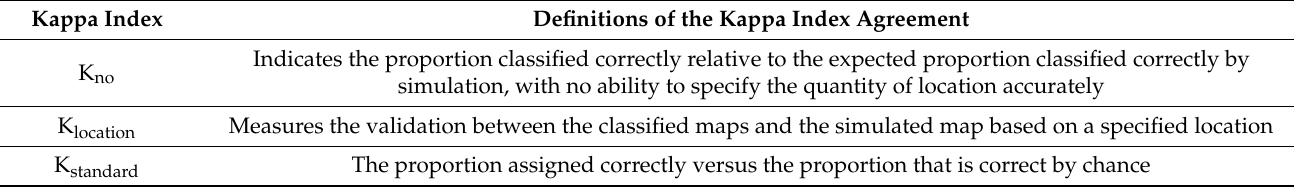
Table 3. Definitions of Kappa